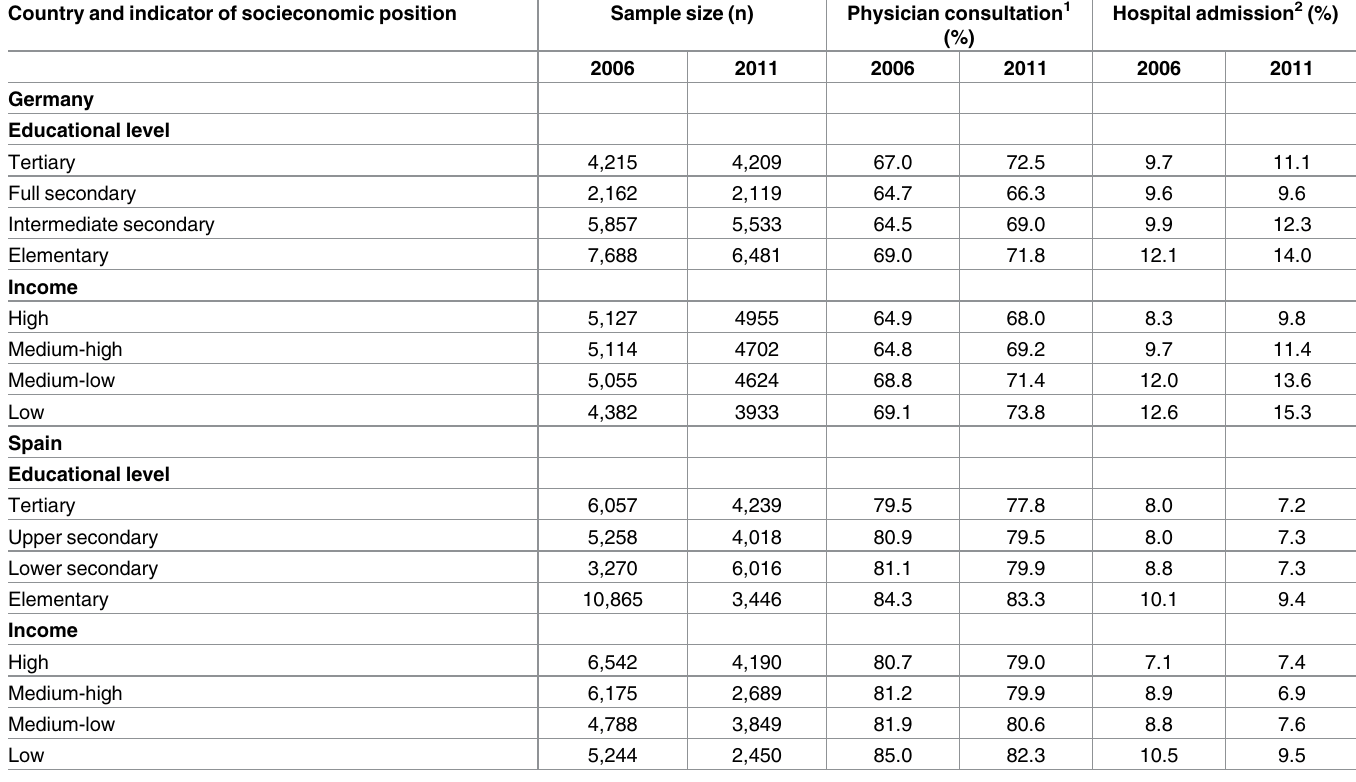
Table 2. Sample size, frequency (in percentage) of physician consultations and of hospitalization, by educational level of head of household and by household income. Germany and Spain, 2006 and 2011. Country and indicator of socieconomic